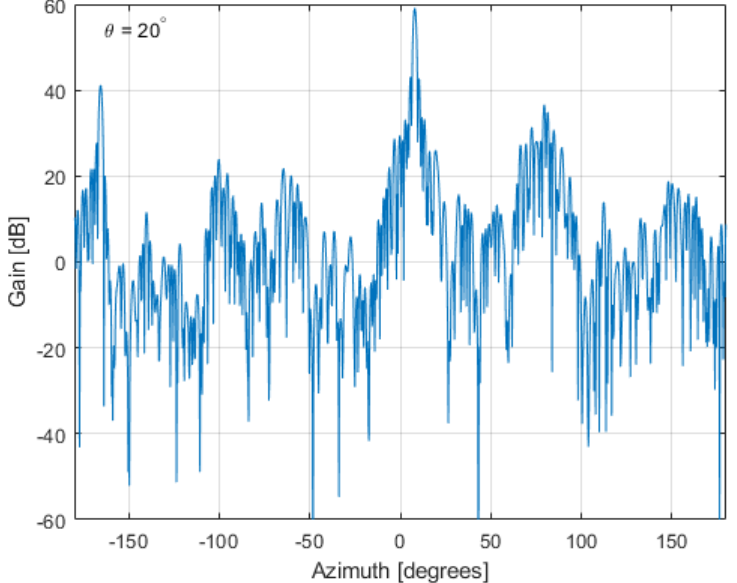
Figure 15. Horizontal cut at 20 ◦ elevation of the beam pattern of the LOFAR station with the beam steered at φ st = 8 ◦ and θ st = 20 ◦